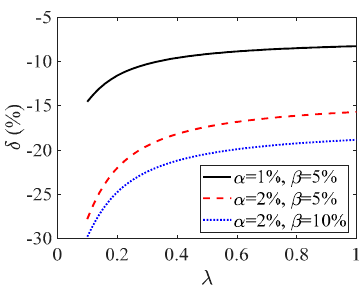
Figure 7. δ changes with λ under different values of α and β .